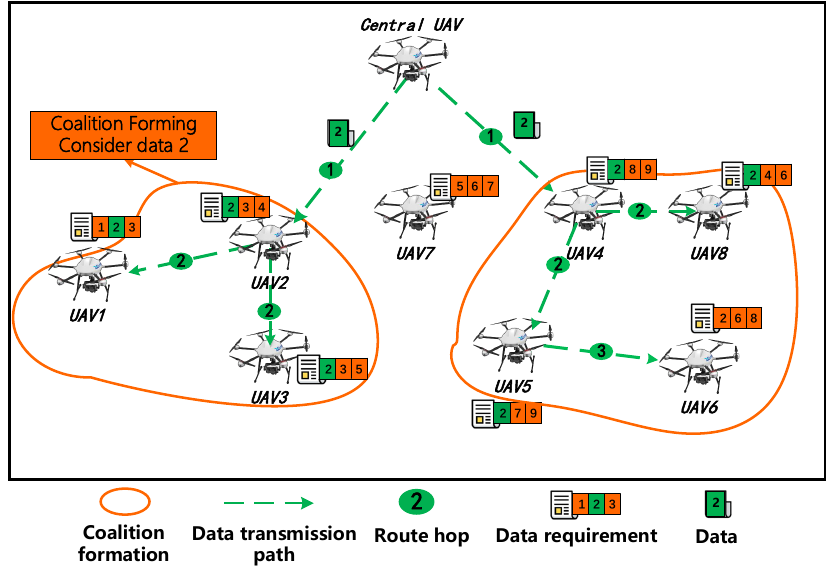
Figure 1. A diagram of data multi-hop transmission considering coalition formation in UAV